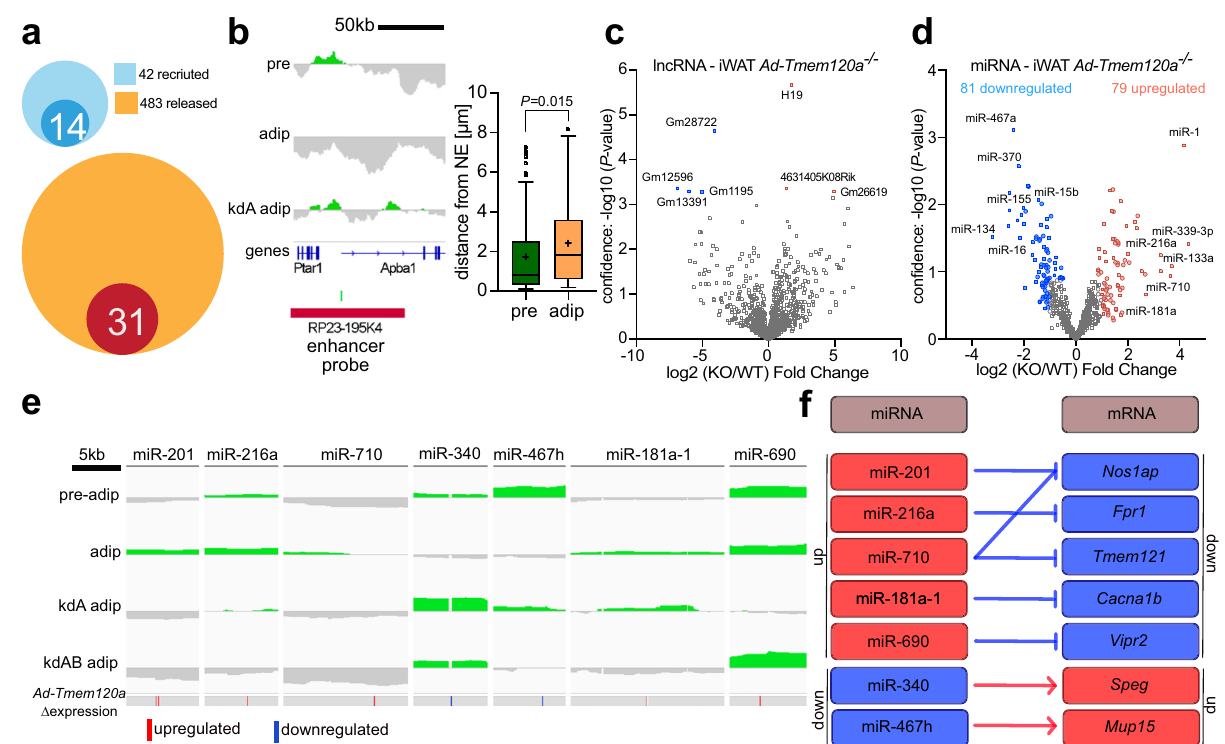
Fig. 6 Enhancers and regulatory RNAs under NE positional control. a Venn diagrams showing proportion of predicted adipogenic enhancers that become lost during adipogenesis — recruited to NE (light blue) or new adipocyte enhancers – released from NE (yellow). Dark blue circle represents enhancers that fail to recruit to NE during adipogenesis in Tmem120a KD 3T3-L1 cells. Red circle represents enhancers that fail to release form NE during Tmem120a KD 3T3-L1 differentiation. b DamID trace and FISH loci signal distance from NE quanti fi cation of the Klf9 enhancer shown as Tukey box plot representing median, cross on the box represents mean, bounds of box represents interquartile of the data, whiskers representing minima/maxima excluding outliers and dots represents outliers of more than 2/3 times of upper quartile. Pre-adipocytes (pre) and adipocytes (adip) n = 73 loci for both groups. P value was calculated by unpaired, two-sided, Student ’ s t test, c Volcano plot showing expression of lncRNA, highlighting strong upregulation of the H19 expression in Ad-Tmem120a − / − iWAT. d Volcano plot of differentially expressed miRNAs in iWAT. e DamID traces showing the position of miRNA-encoding loci with respect to changing LADs and their expression change in the knockout mouse. Blue, downregulated; red, upregulated. f Target genes of differentially expressed miRNAs show corresponding expression changes (RNA-Seq). See also Supplementary Data 5. Source data are provided as a Source Data fi